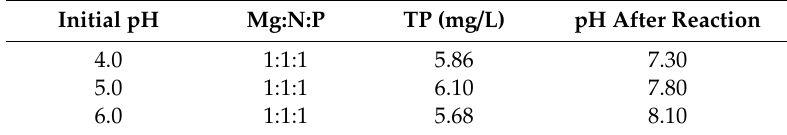
Table 2. Concentration of total phosphorus (TP) after reaction at di ff erent initial